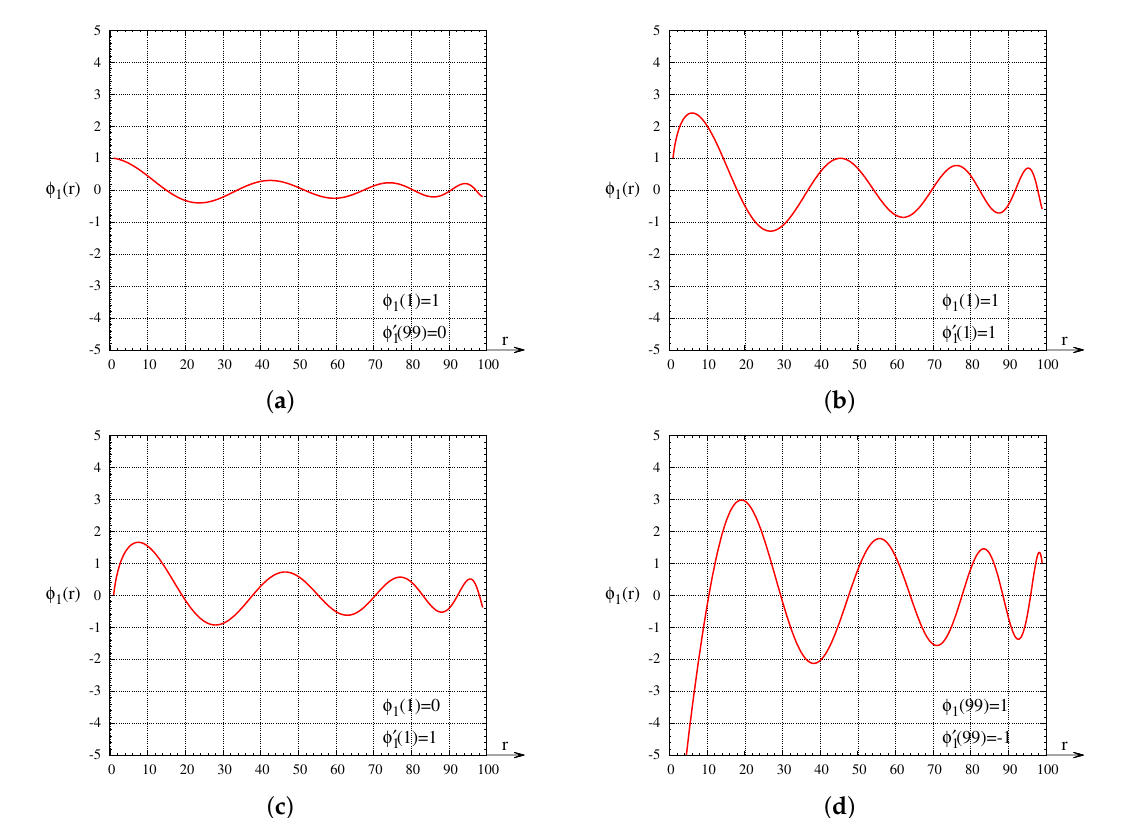
Figure 1. Representation of the non-trivial radial behavior φ 1 ( r ) for concentric wave propagation on the Einstein cylinder with length scale a = 100. The amplitude A + and the speed c are both normalized to unity. The frequency is always ω = 1/2 π . For illustrative purposes, different boundary conditions are chosen, and they are individually given in the legend of all subfigures. In cases ( a – c ), a characteristic wave damping is observed. Case ( d ) shows a wave traveling inwards from the equator to the